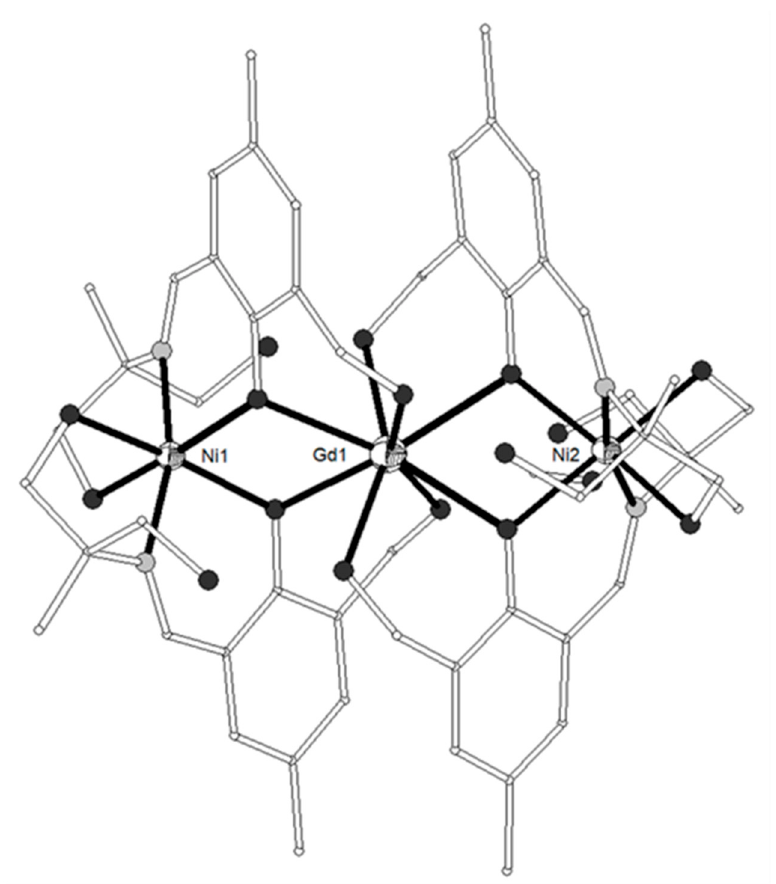
Figure 7. The molecular structure of the cation [{Ni(H 3 L 13 ) 2 } 2 Ln] 3+ in complex 76 . Color code as in Figure 2 [33].